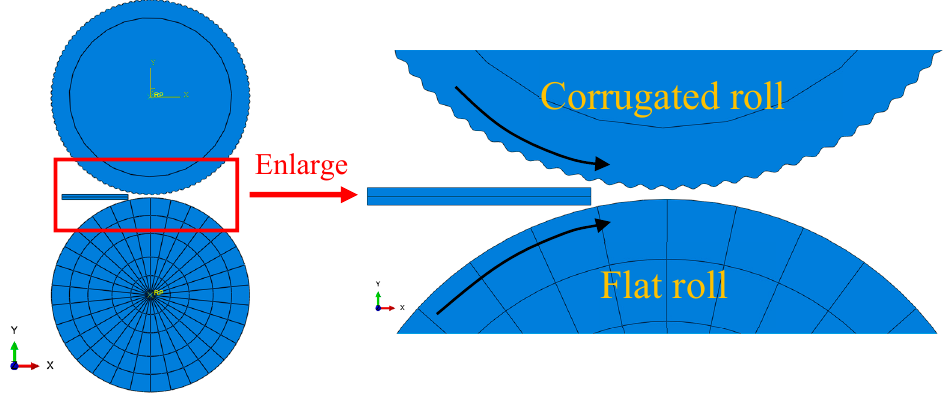
Figure 3. Schematic diagram of numerical simulation for the corrugated rolling process.